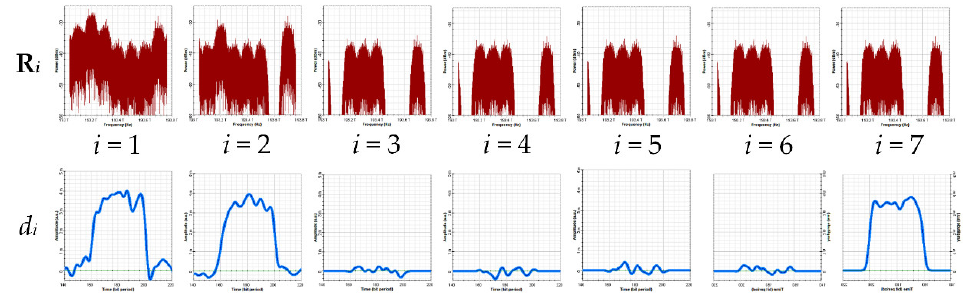
Figure 7. Variations of the time-domain waveforms and the power spectral density (PSD) at the seven stages of interference cancellation.